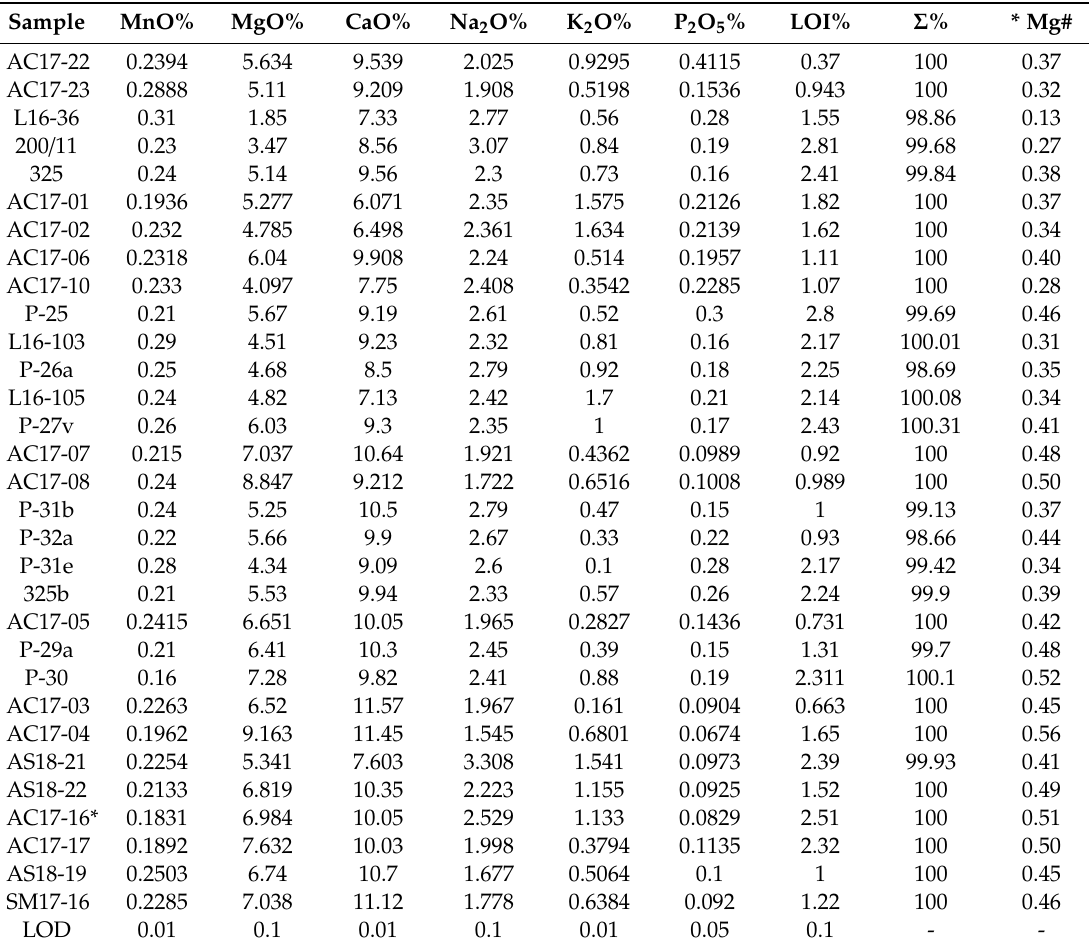
Table A2. The results of whole-Rock Major and Trace Element Measurements (continuation).